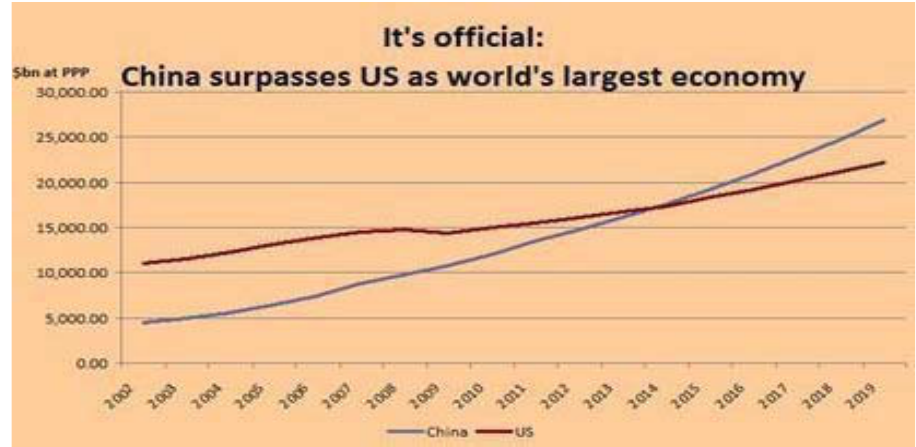
Fig. 4. China becomes world’s largest